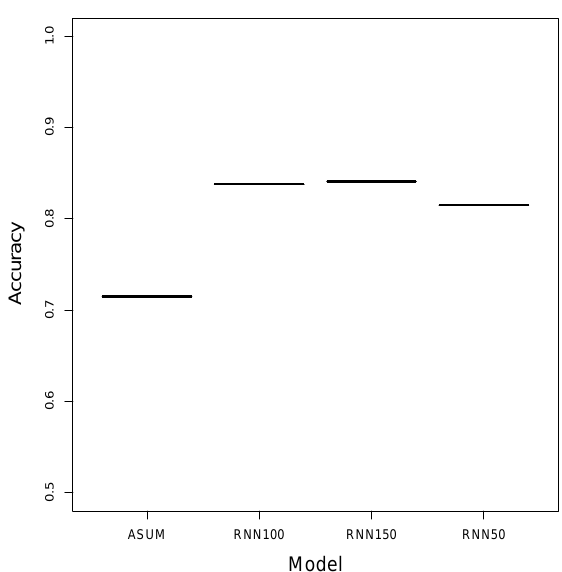
Figure 2. Accuracy comparison under the RNN with different numbers of hidden layers and the Aspect and Sentiment Unification Model (ASUM). RNN50, RNN with 50 hidden layers. RNN100, RNN with 100 hidden layers. RNN150, RNN with 150 hidden layers.